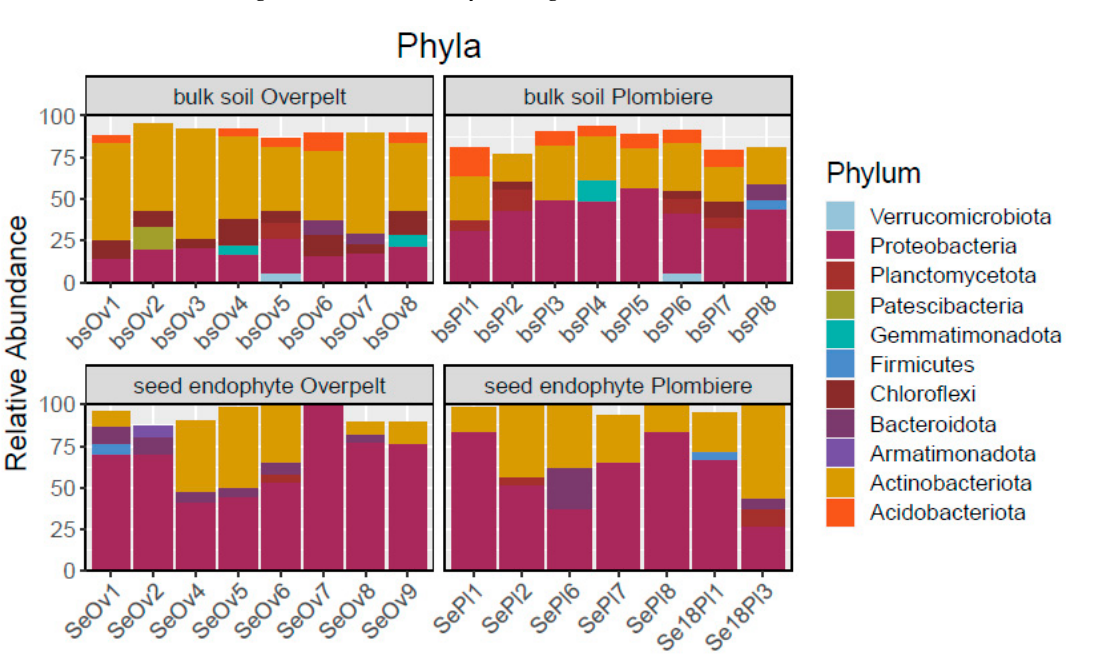
Figure 2. Phyla community results of N. caerulescens from two locations—Overpelt and Plombi è res, Belgium—separated into compartments addressing the bulk soil and the seed endophytes. Species richness between the two sampled sites indicates similar diversity at both locations. Species richness in the seeds from Plombi è res shows a more conserved range of bacteria. The Shannon–Wiener index show significant differences between the microbe life present within the bulk soil when compared to the more selective seed endophytes present at Plombi è res (Figure